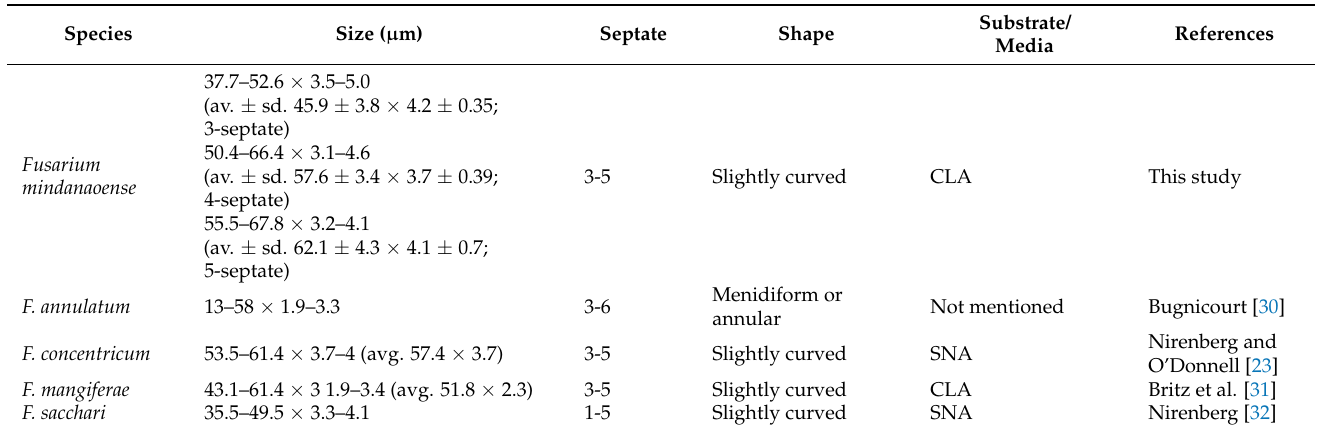
Table 2. Comparison of the size, septation, and shape of sporodochial conidia among related species of